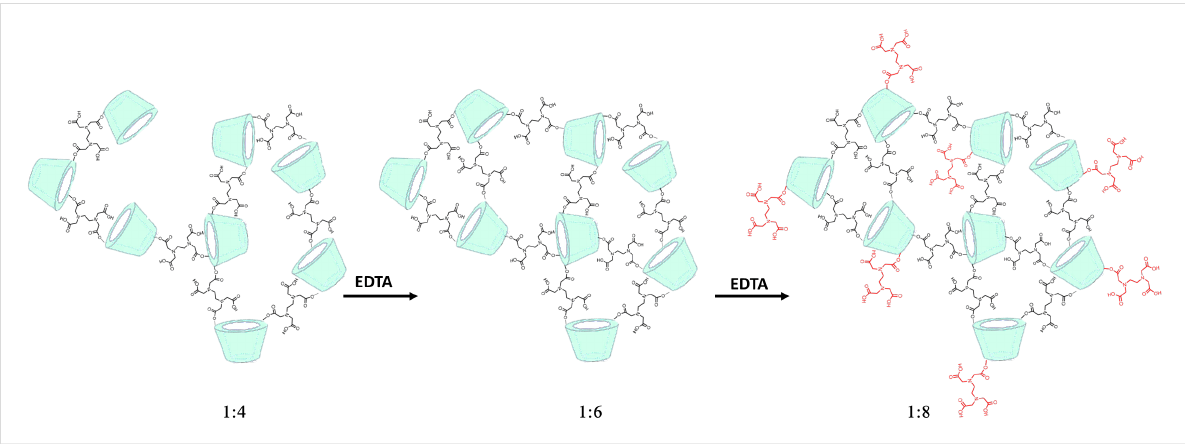
Figure 5: Effect of the increasing amount of crosslinker with respect to CD (expressed here as mol of crosslinker per mol of CD) on CDNS structure. The cross-linking degree increased up to 1:6, then further excess of EDTA causes branching of CD units rather that further cross-linking.